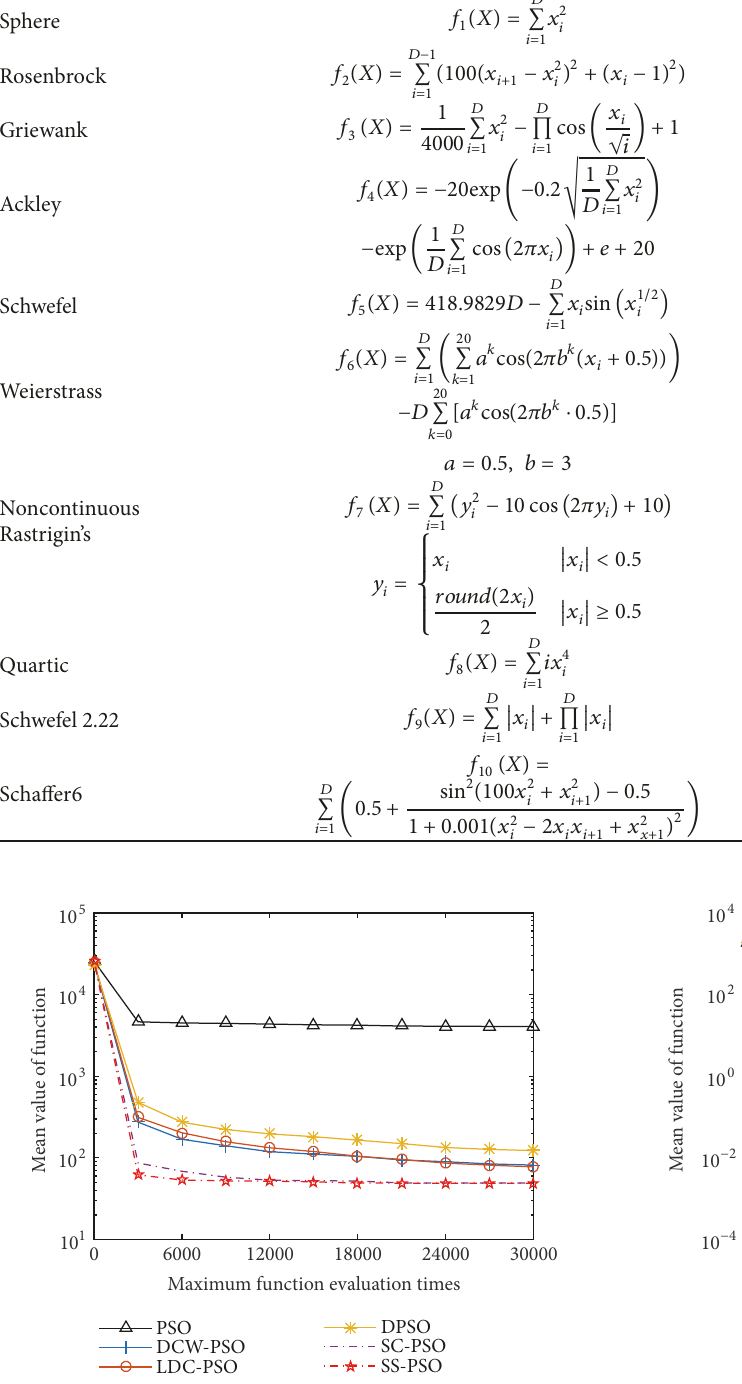
Figure 5: The function f 3 iterates over the